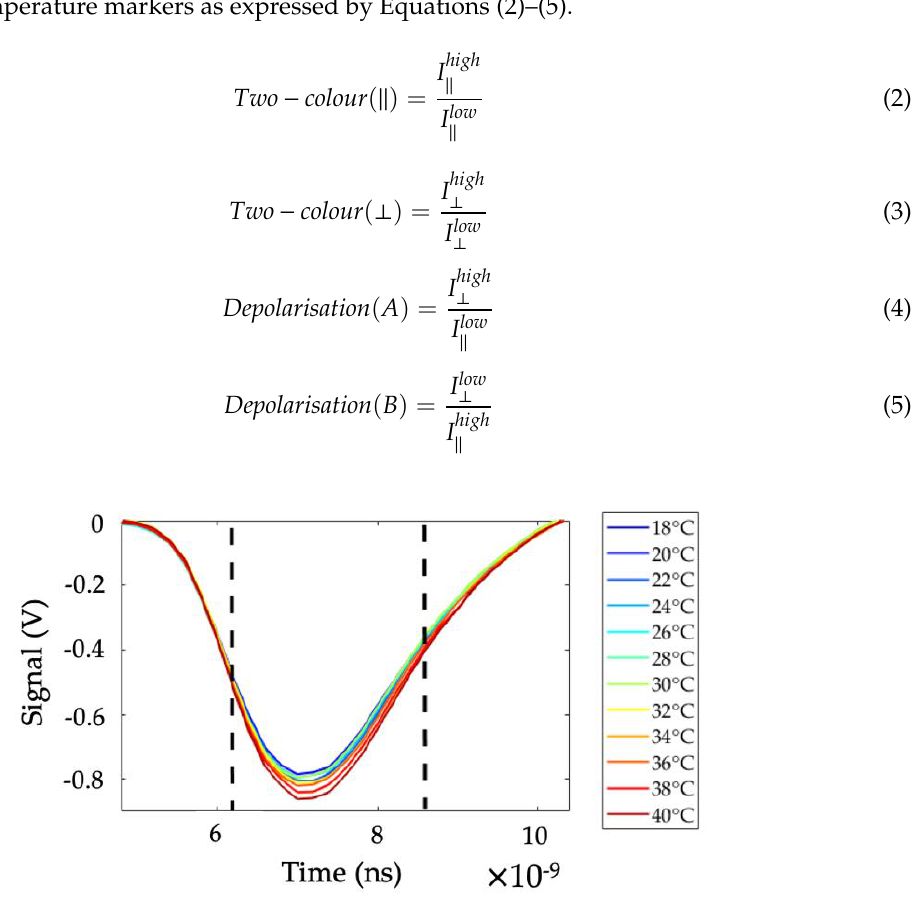
Figure 4. A typical set of signals (channel 1), recorded for different temperatures and showing the area over which the signals were integrated.